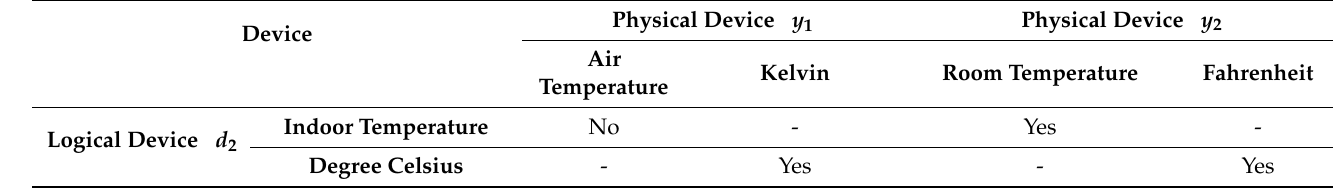
Table 2. Compatibility check result for logical device d 2